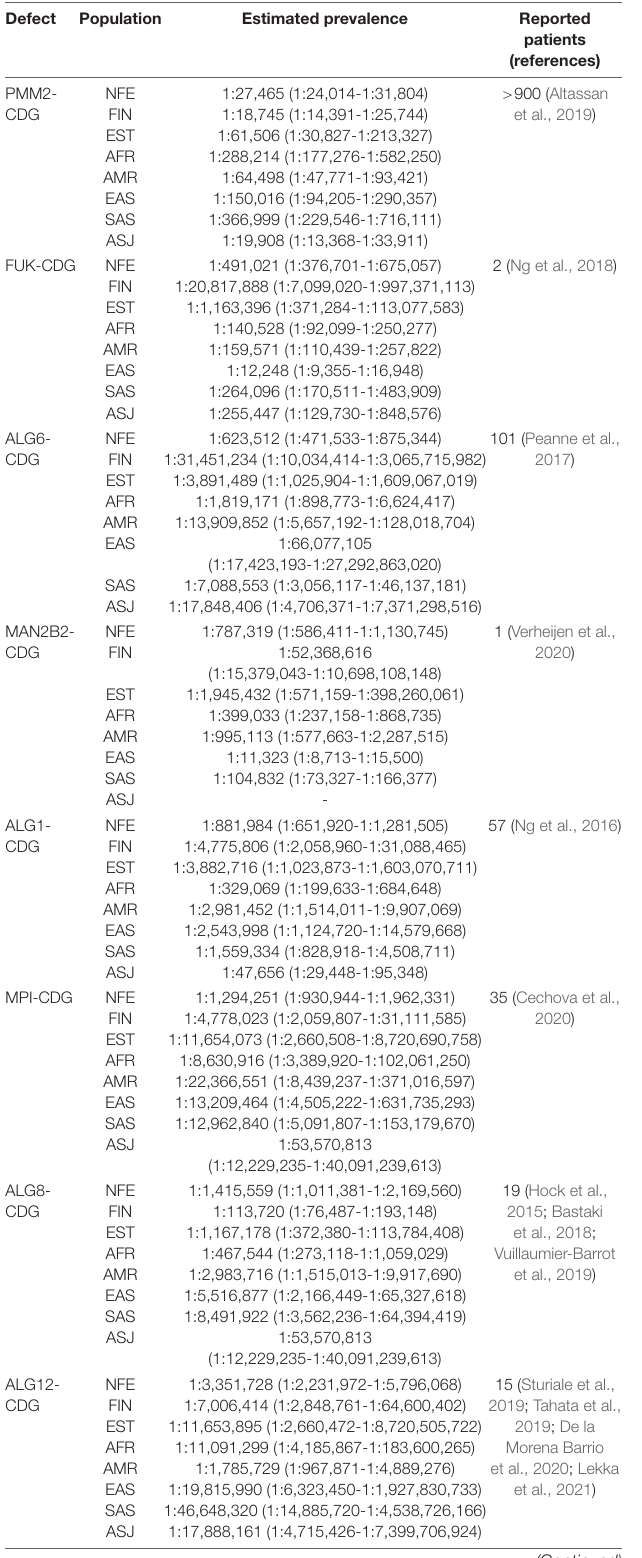
TABLE 1 | N-linked protein glycosylation defects with highest estimated prevalence. Defect